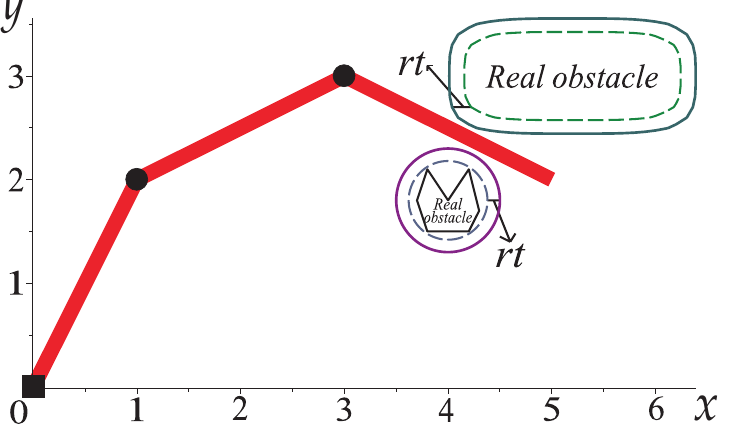
Figure 13. Representation of a safeguard radius ( rt ) of an obstacle in a workspace with a robotic